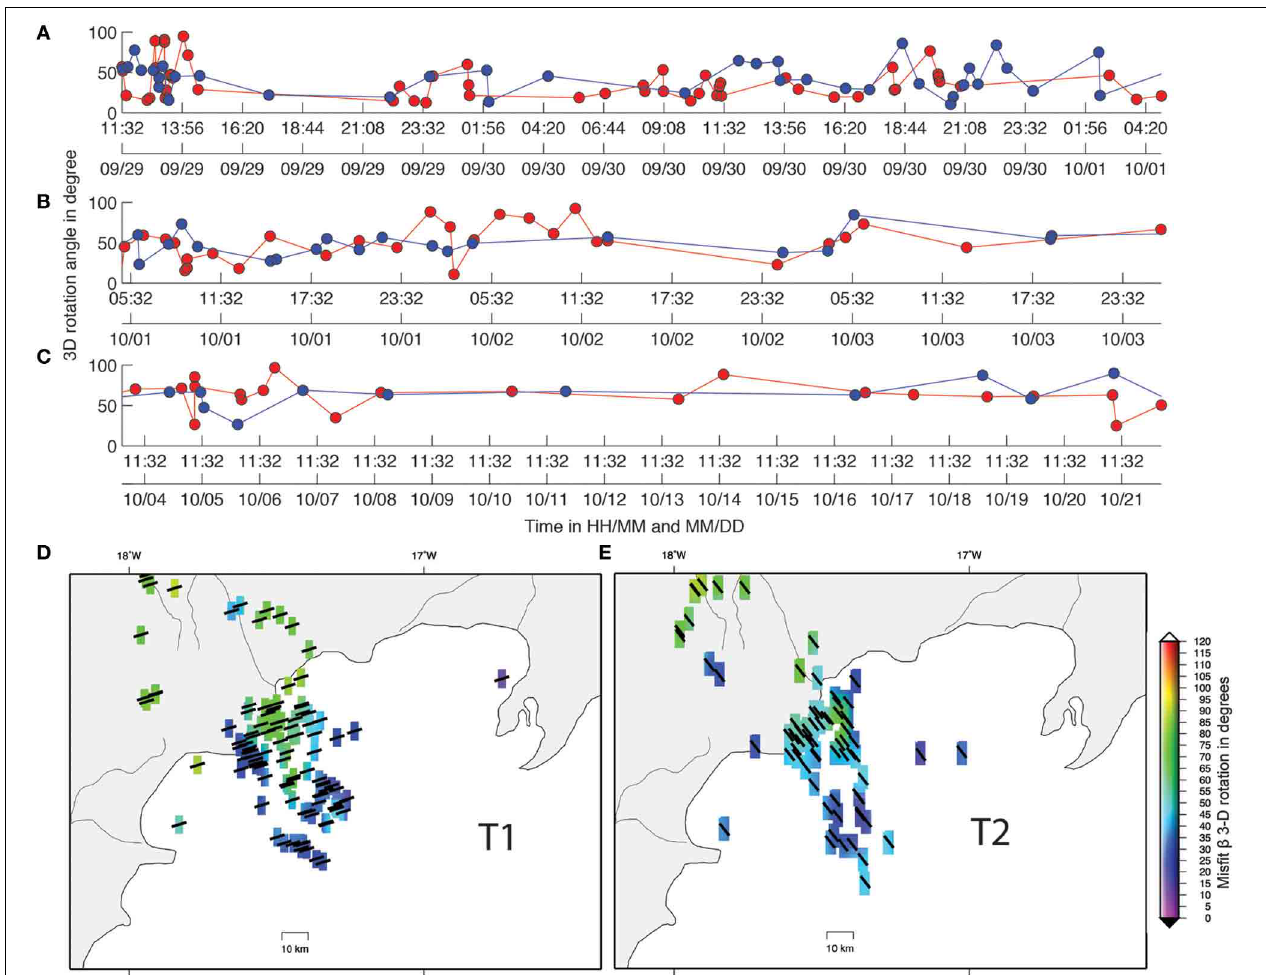
FIGURE 13 | Distribution in time and in space of the tectonic regimes T1 and T2 during the 1996 eruption. (A–C) shows the 3D rotations angle β of each focal solution (Kagan, 2007) compared to the frame Q T1 for T1 in red and the frame Q T2 for T2 in blue respectively in y-axis and the time in x-axis, the dots represent the seismic events (see section Occurrence of the State